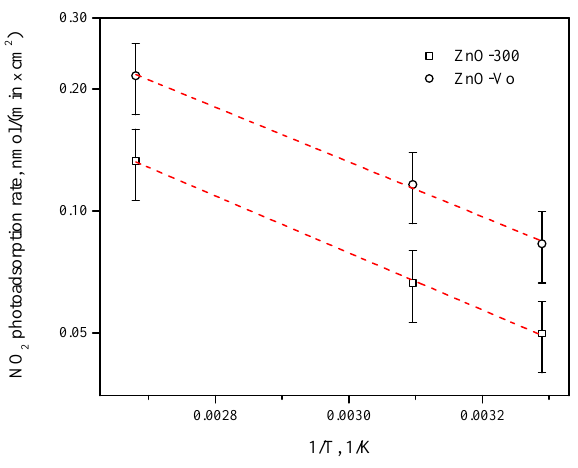
Figure 14. Temperature dependence of the rate of NO 2 photoadsorption under UV irradiation (370 nm) from an oxygen-rich atmosphere (He + 20% O 2 + 100 ppm NO 2 ) on the ZnO surface on the Arrhenius